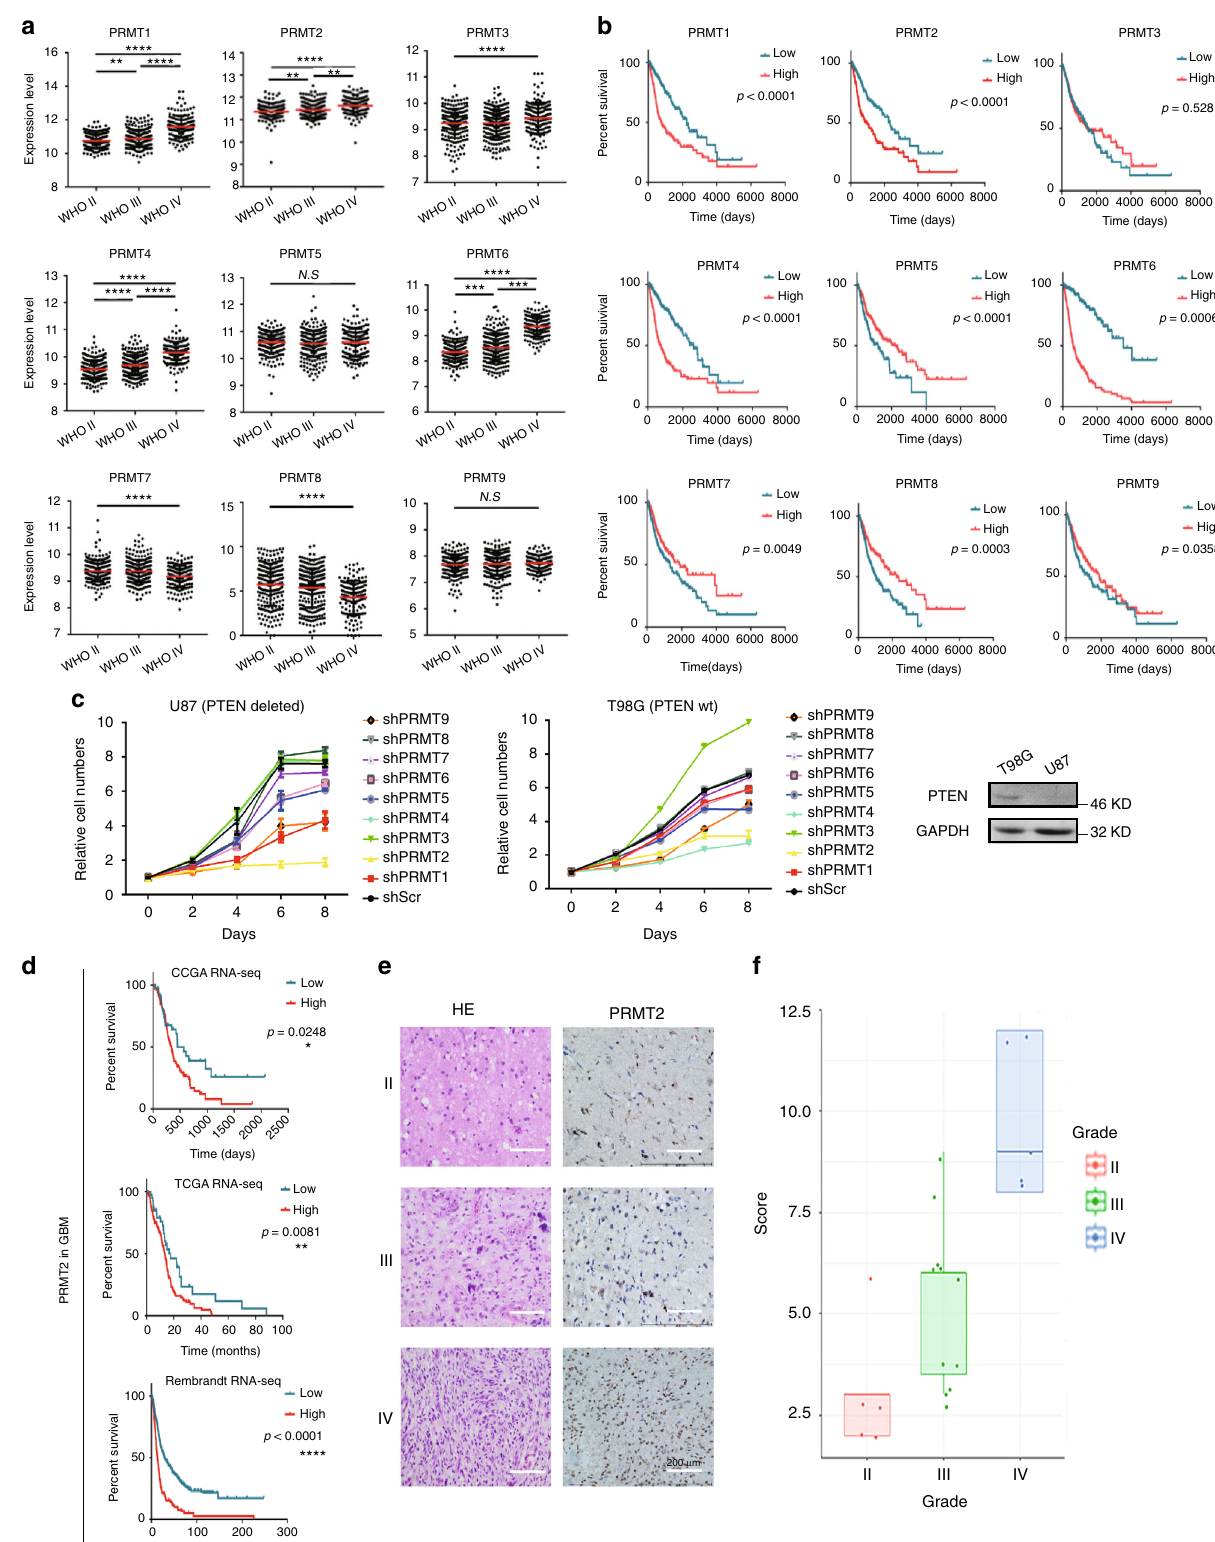
hairpin RNAs (shRNAs) (shPRMT2-1 and shPRMT2-2) in U87 and T98G cells. Upon an effective depletion of PRMT2 as tested by real- time quantitative PCR (RT-qPCR) and western blot (WB) assays (Fig. 2a, b), the cell growth in either colony formation in soft agar or monolayer culture, is signi fi cantly inhibited (Fig. 2c, d). Notably, NATURE COMMUNICATIONS| (2018) 9:4552 |DOI: